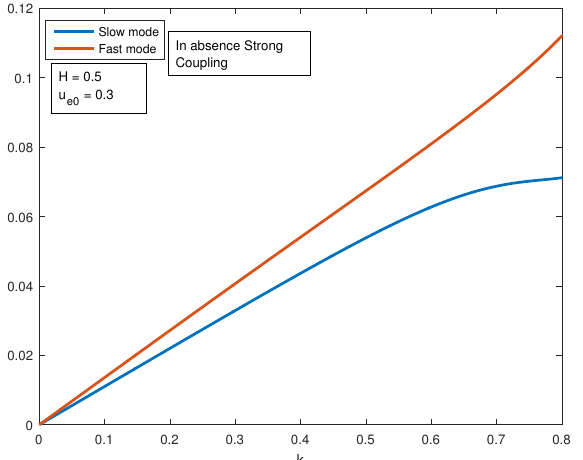
Figure 6. The figure depicts the ‘fast’ and ‘slow’ modes of excitation in absence of strong coupling but for the classical situation.